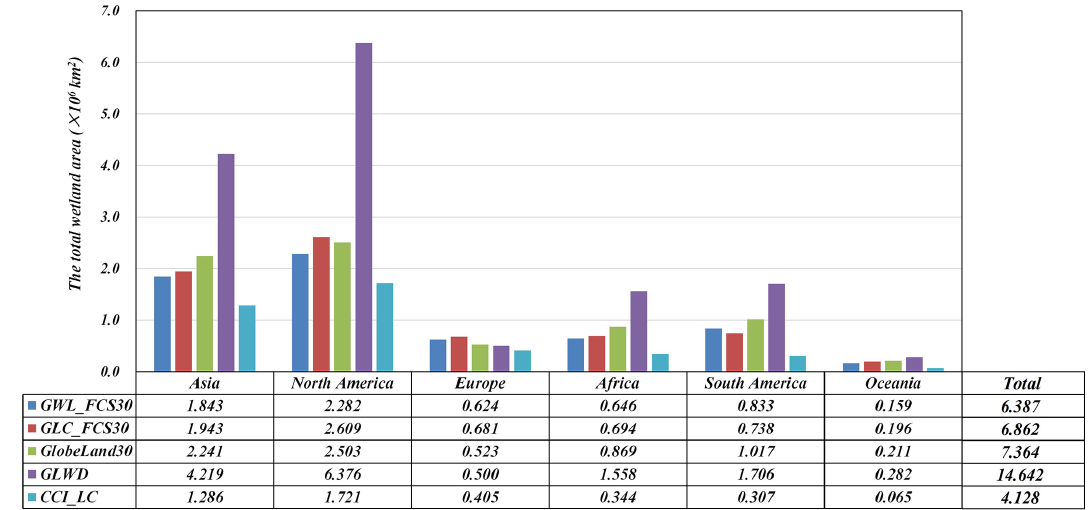
Figure 12. The total wetland area (unit: millionkm 2 ) of five global wetland products on six continents.